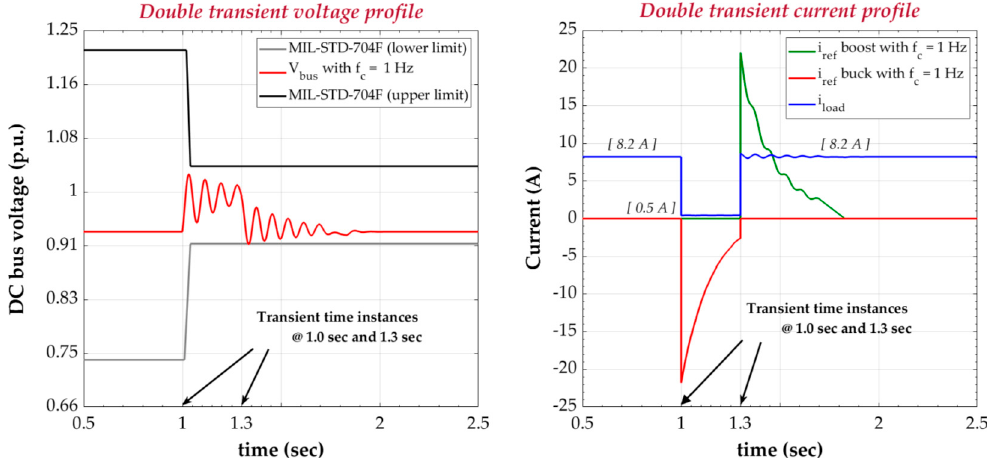
Figure 14. DC bus voltage and current profiles for a double voltage transient.